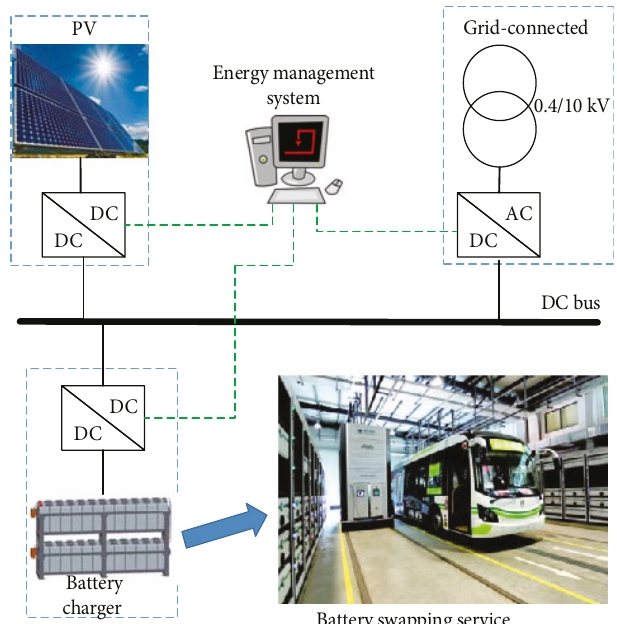
Figure 1: Structure of a PV-based BSS.